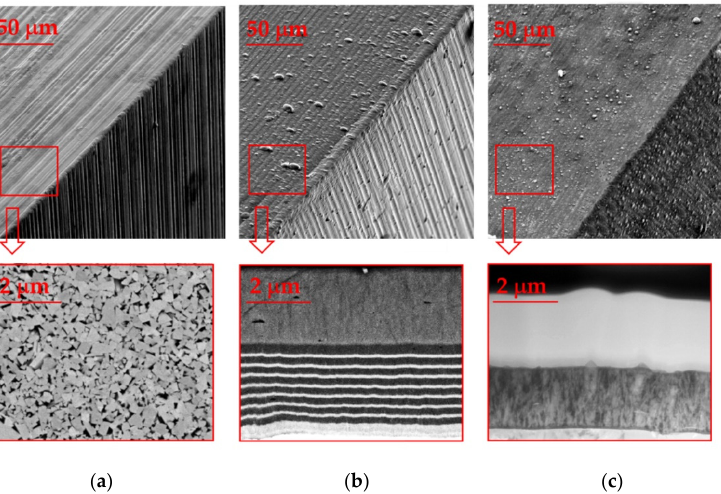
Figure 5. Surface morphology and surface layer structure of ball end mills: ( a ) uncoated cemented carbide; ( b ) with TiN–AlN–TiAlN coating; ( c ) with CrAlSiN–DLC coating.